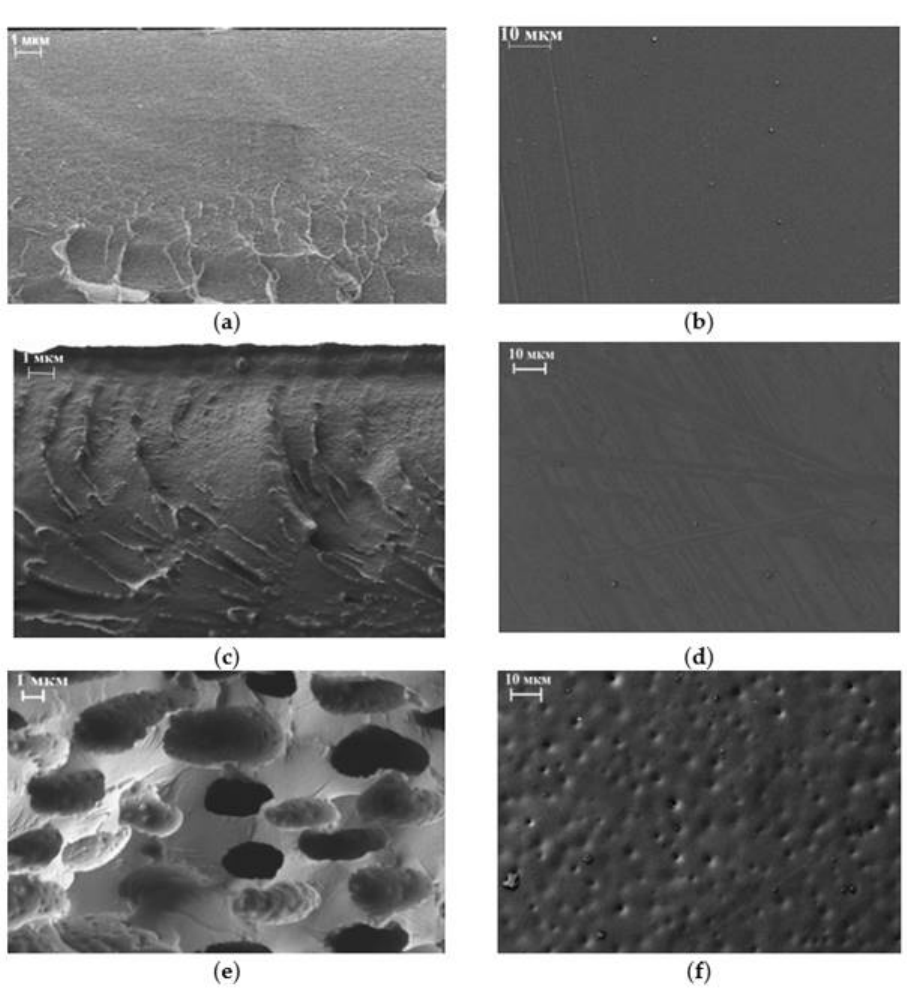
Figure 2. SEM micrographs of membrane surface ( b , d , f ) and cross-section ( a , c , e ): Torlon ( a , b ); Torlon/DES-5 ( c , d ); Torlon/DES-50 ( e , f